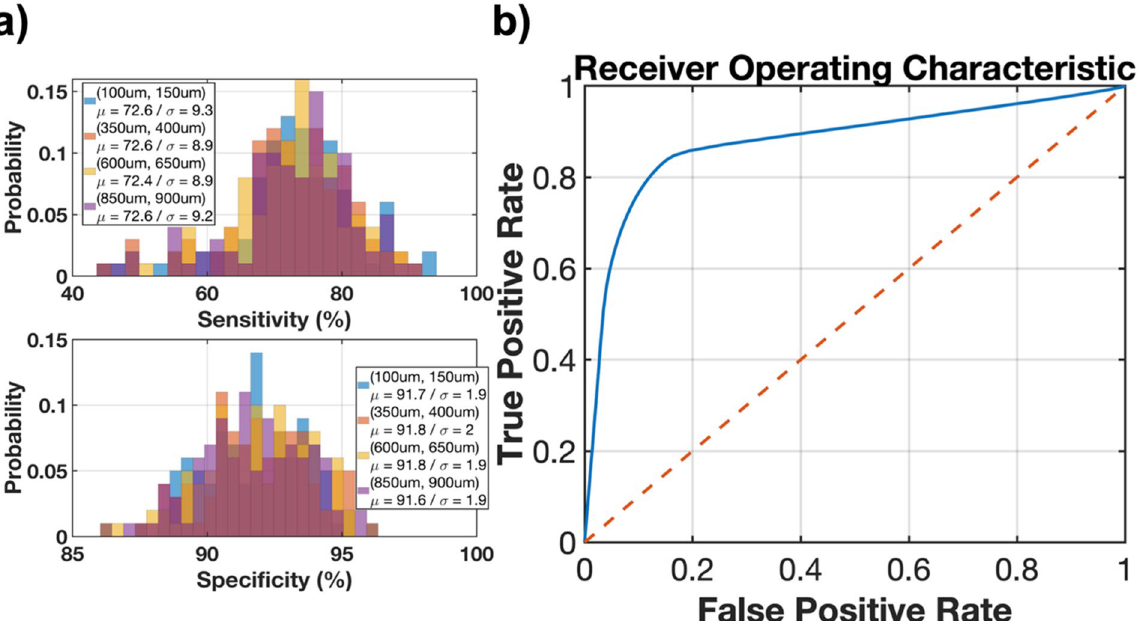
Figure 6. Performance of the compounded module with the moving cell foci: ( a ) Sensitivity and specificity of the ResNet + CNN with 2-sensor network in detecting dynamics of the moving cell cluster for each layer. ( b ) Receiver Operating Characteristic (ROC) of the model averaged for all layers.